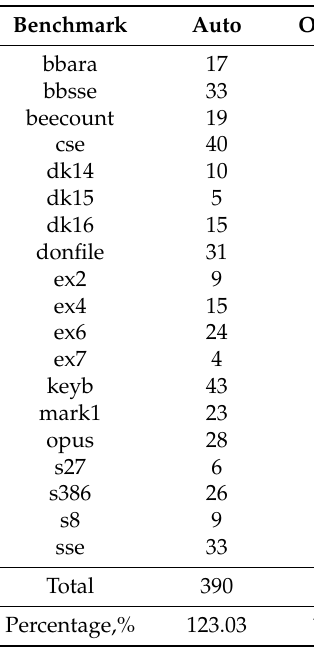
Table 8. Experimental results for category 1 (the number of LUTs).